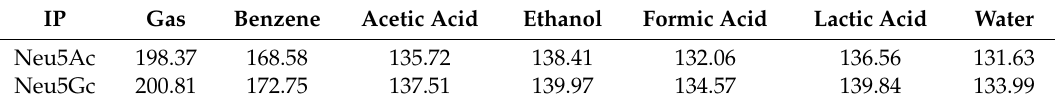
Table 7. The ionization potential (IP) values of Neu5Gc and